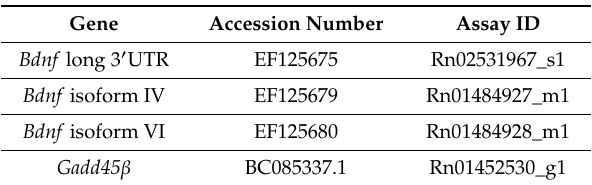
Table 3. Accession numbers.